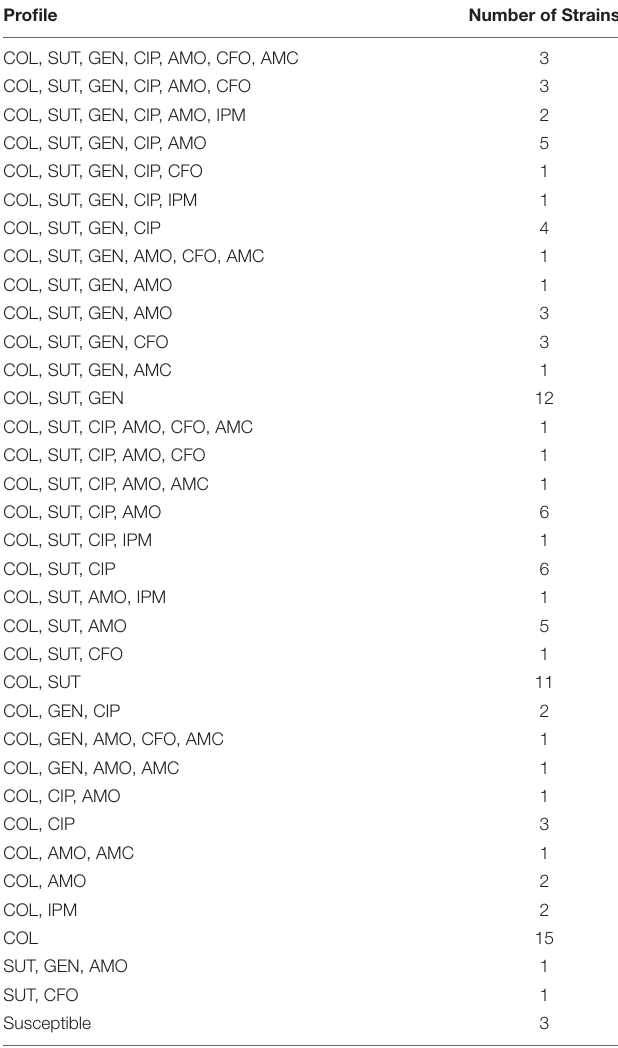
TABLE 2 | Antimicrobial resistance profiles among isolates